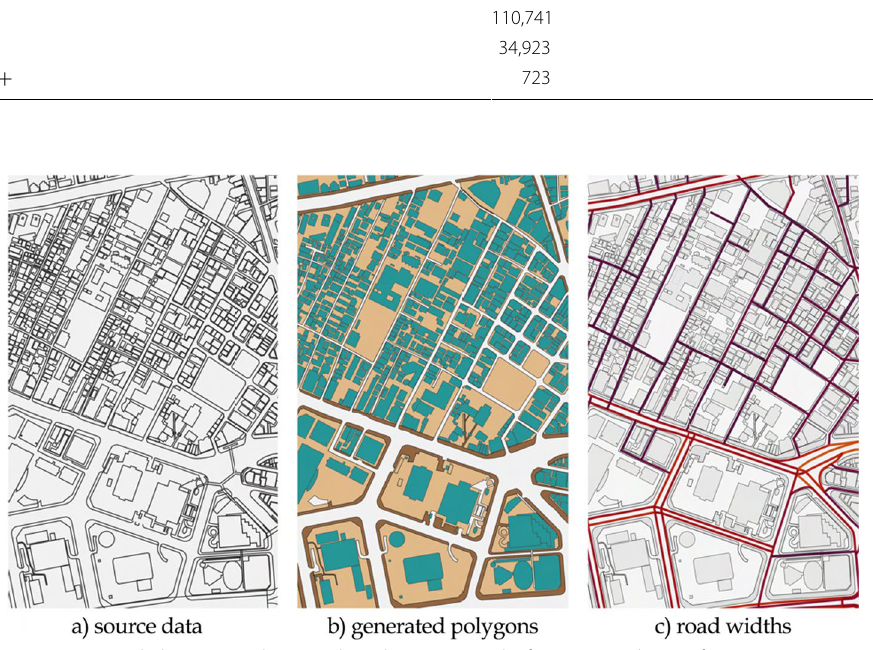
Fig. 1 Steps needed to process the raw “Kiban” data (Geospatial Information Authority of Japan 2022) into usable geospatial information such as road width and sidewalk coverage. Part of the West Shinjuku area mapped using keplergl